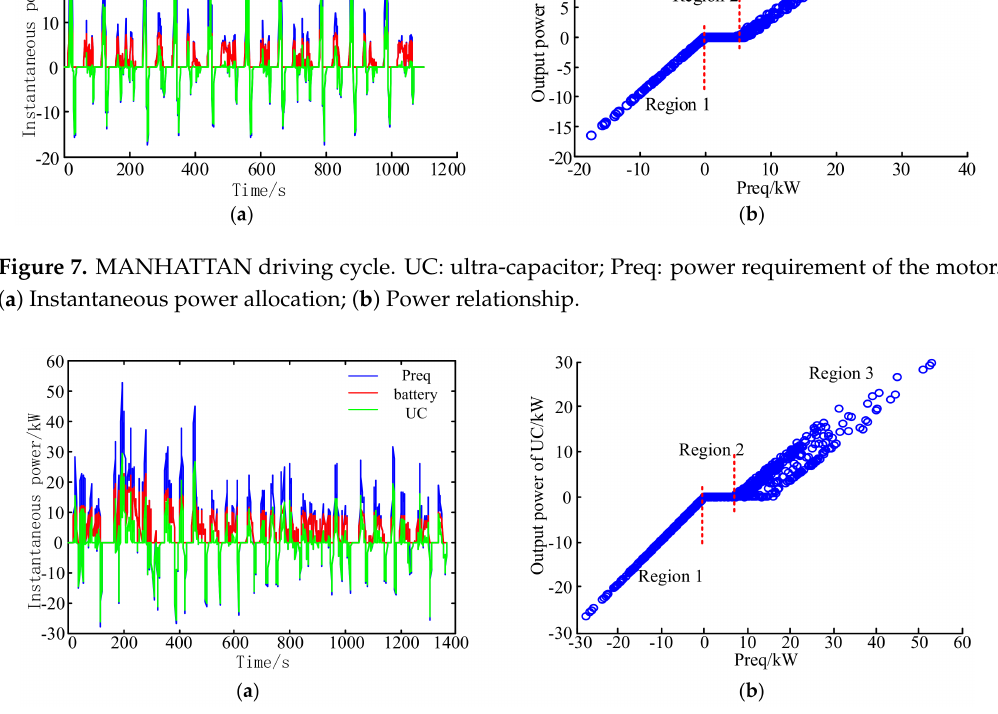
Figure 8. The Urban Dynamometer Driving Schedule (UDDS) driving cycle. ( a ) Instantaneous power allocation; ( b ) Power relationship.